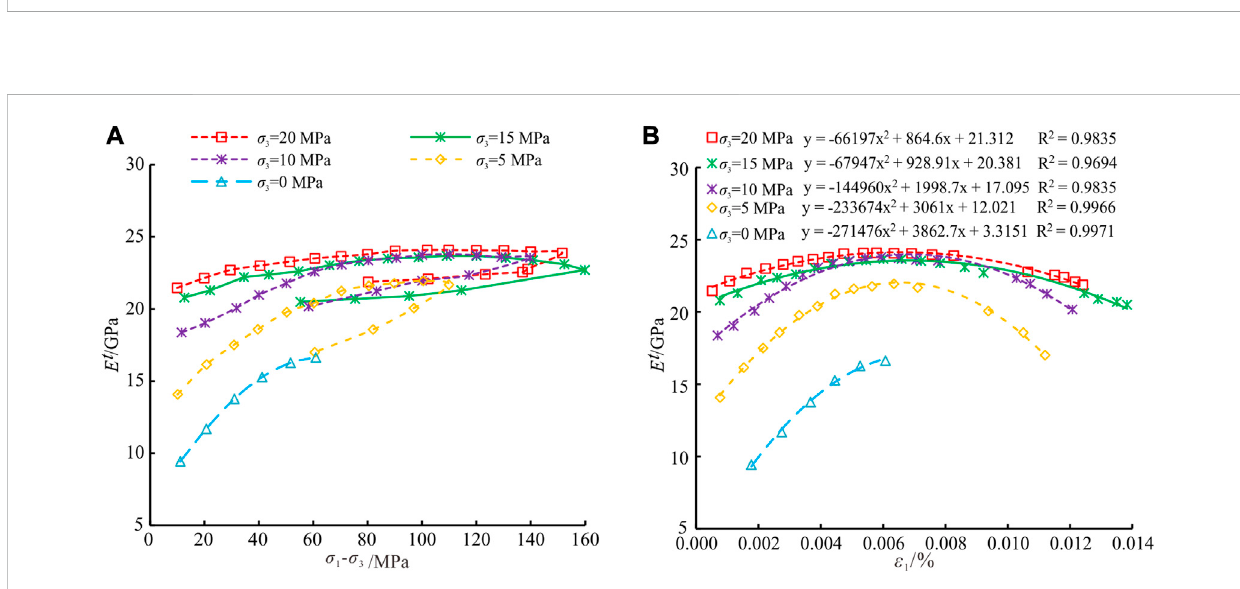
Frontiers in Earth